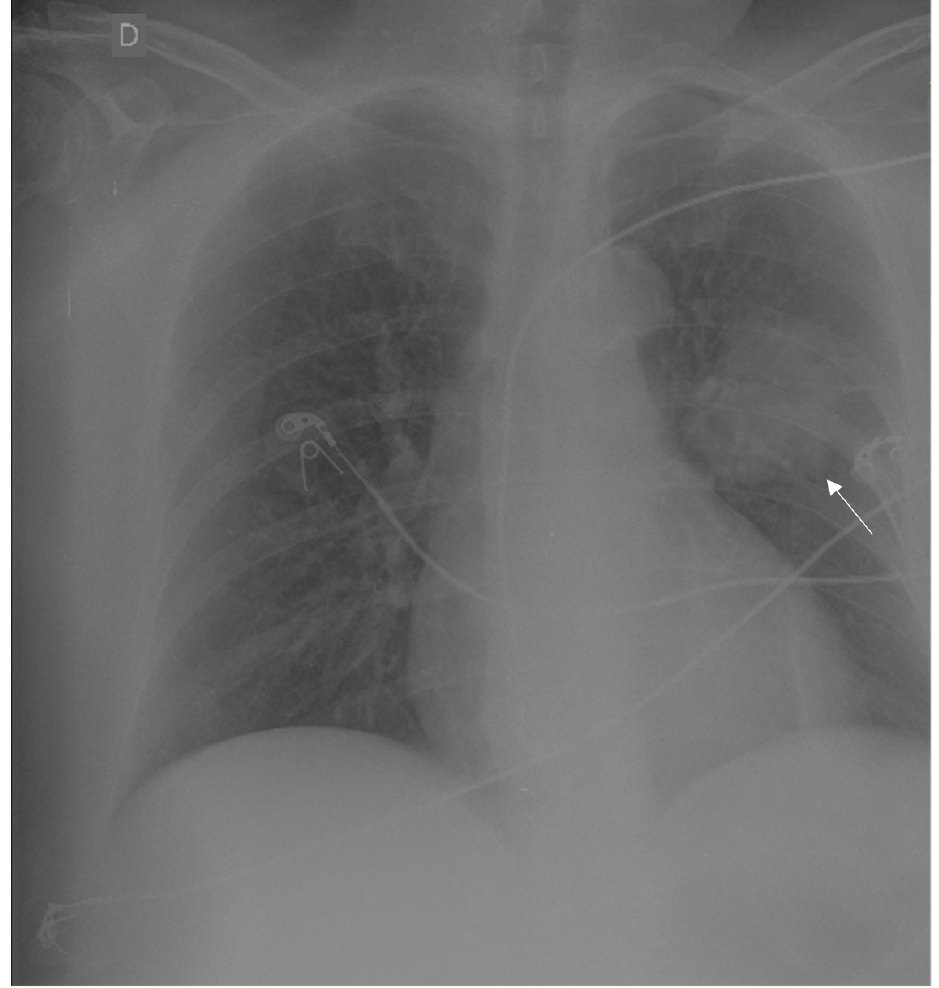
Figure 1. Chest X-ray showing a round mass in the upper lobe of the left lung (indicated with an arrow) suggestive of lung cancer (D in the image means right side).